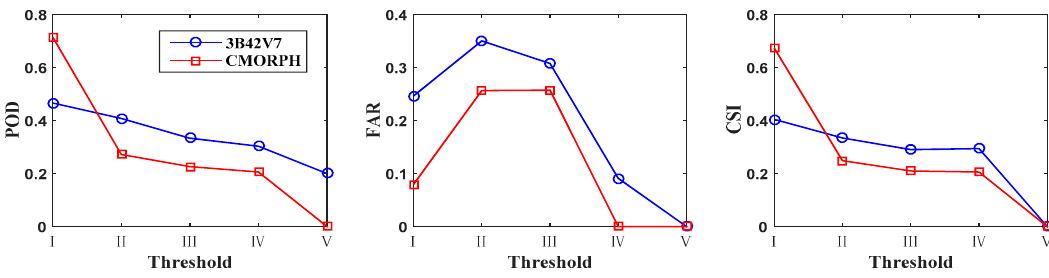
Figure 2. The overall detection capacity of 3B42V7 and CMORPH in different rainfall thresholds.